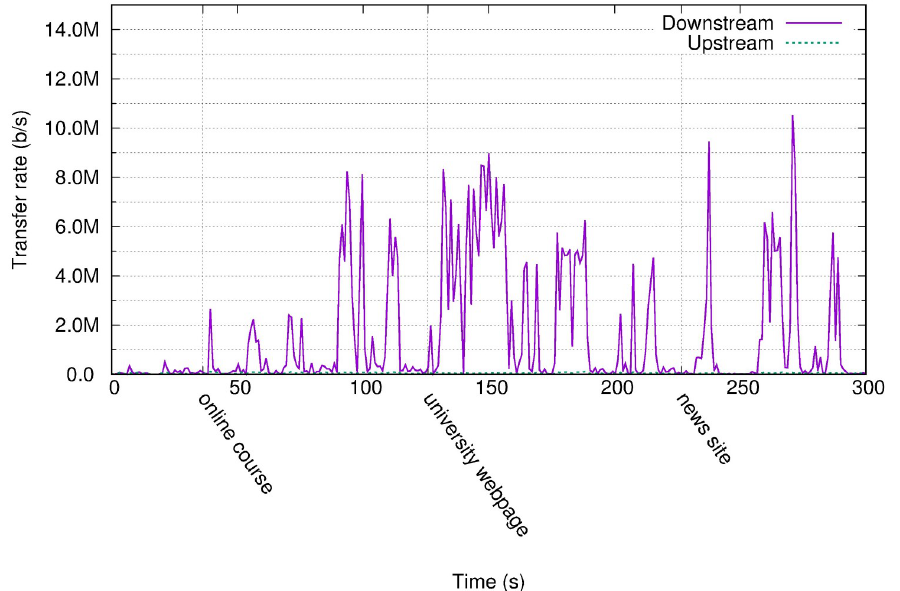
Fig 3. Transfer rate for the web profile in Amazon WorkSpaces.